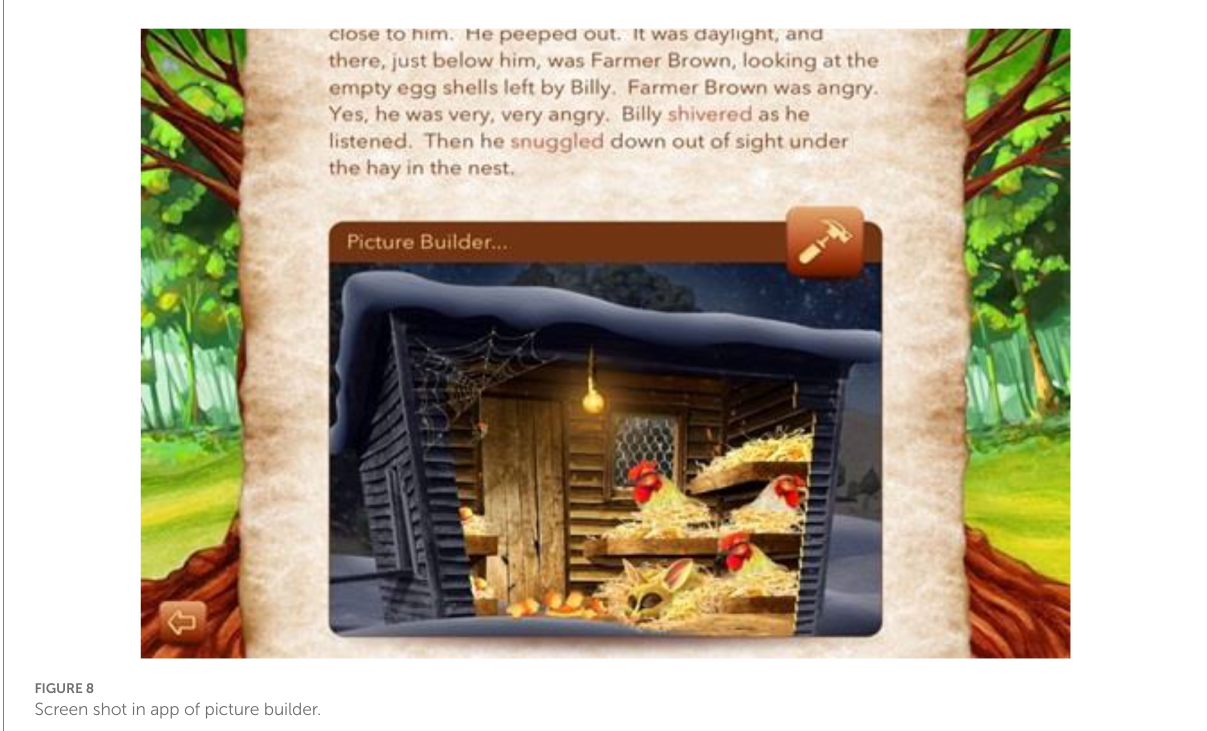
FIGURE 8 Screen shot in app of picture builder.